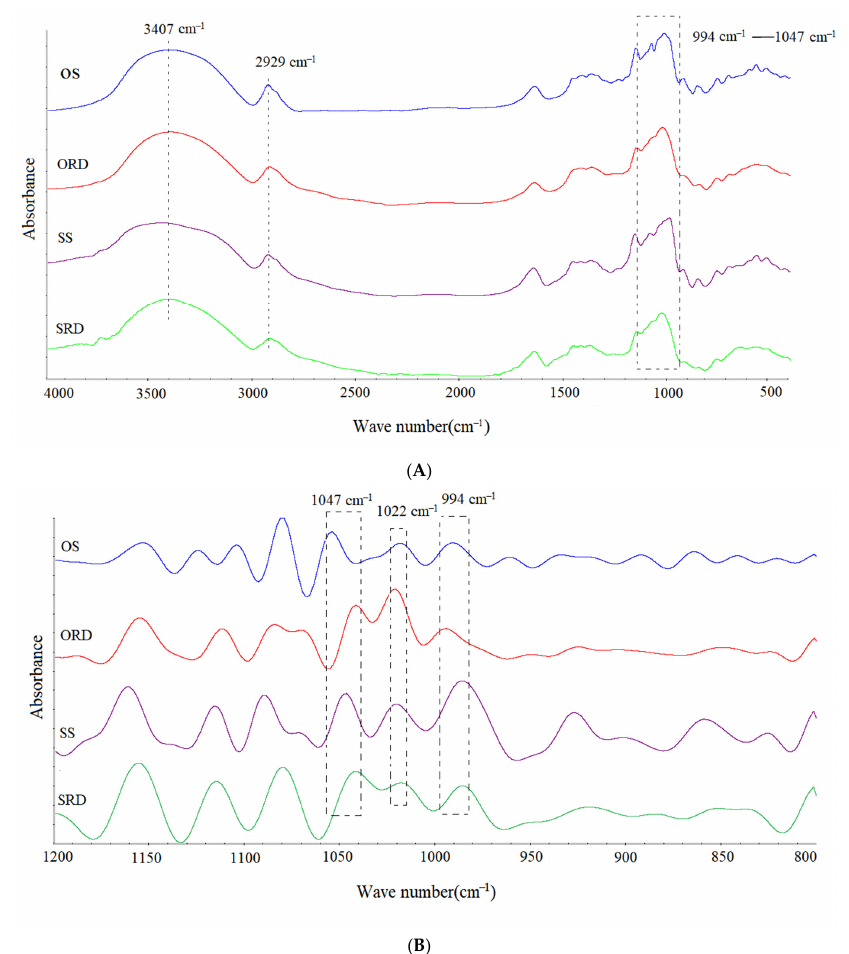
Figure 2. FTIR spectra ( A ) and FTIR spectra after deconvolution ( B ) of sorghum/oat starch and sorghum/oat resistant dextrin. SS: sorghum starch; SRD: sorghum resistant dextrin; OS: oat starch; ORD: oat resistant dextrin.